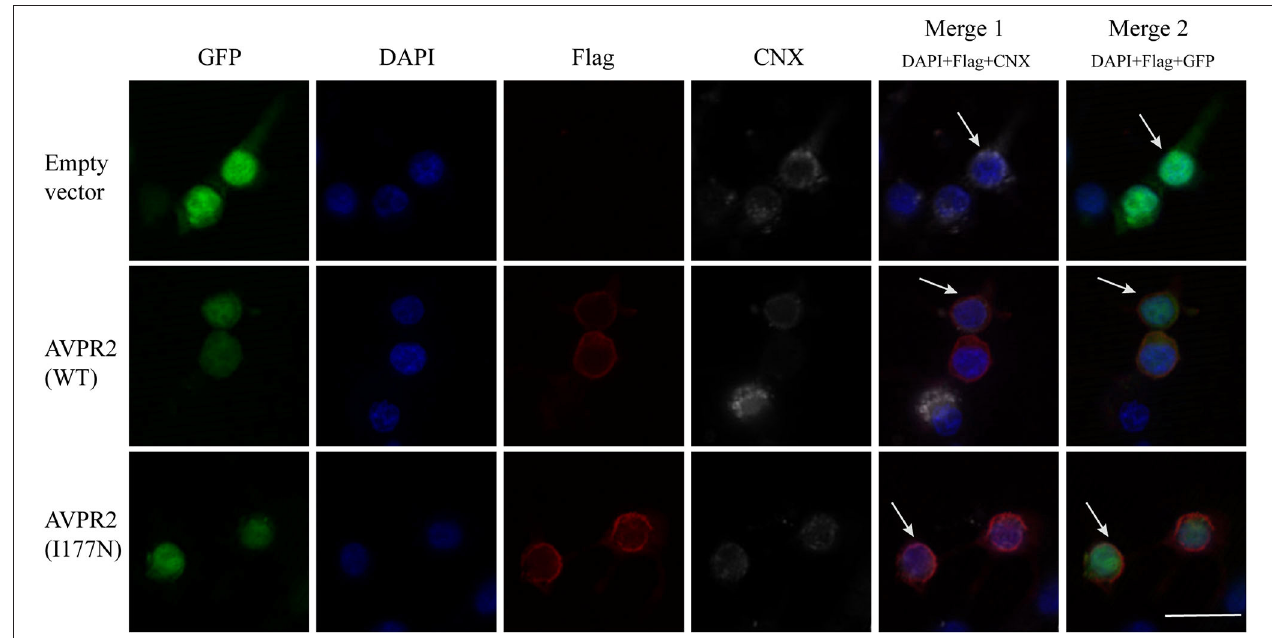
FIGURE 3 | Cellular localization of arginine vasopressin receptor 2 (AVPR2)-I177N. The empty vector or flag tagged AVPR2 or AVPR2-I177N expression vector was transfected into HEK 293T cells. The transfection effect was observed by the expression of green fluorescence protein (GFP), which is not in conjunction with AVPR2. Calnexin (CNX), a marker of ER, marked the ER membrane were shown gray, and the flag tagged AVPR2 proteins were in read. Cell nuclei were counterstained by DAPI (blue). Both single staining and merged images are shown. Both the transfected wild-type and I177N mutant AVPR2 proteins were successfully expressed and could be localized outsider ER, as indicated by the white arrows in the merge 1, and they both could localize on the edge of GFP staining, as showed by the merge 2. The scale bar in the image represents 20 µ m.